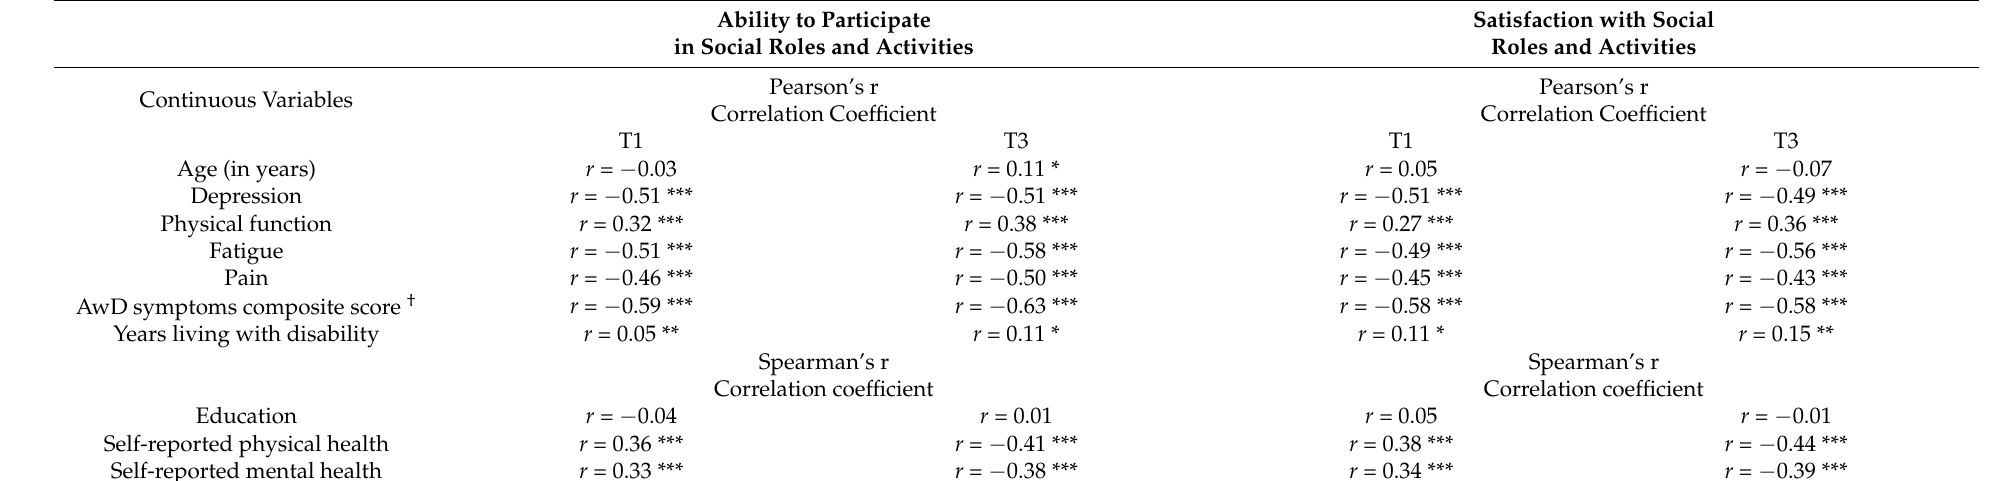
Table 2. Correlations between selected variables and two social participation